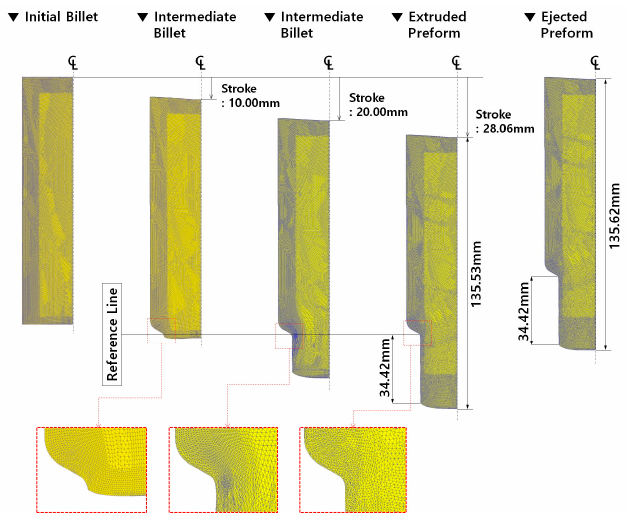
Figure 10. Deformation history during forward extrusion and ejection in the case where elasto-plastic material model was applied.